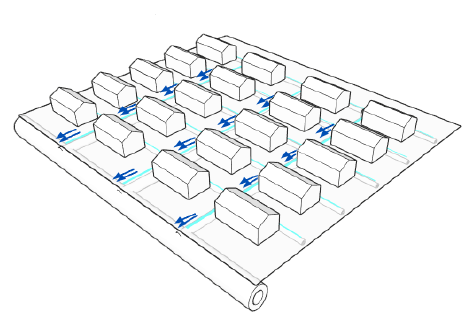
Figure 1. Conventional water